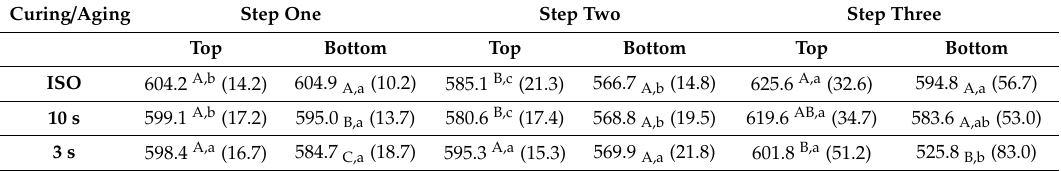
Table 4. Depth-sensing indentation test: Mean Martens’ hardness HM in N / mm 2 (mean and standard deviation). Superscript / subscript letters indicate homogeneous groups; Capital letters indicate sub-groups related to columns; Lowercase letters indicate sub-groups related to rows; Tukey’s post-hoc test ( α =